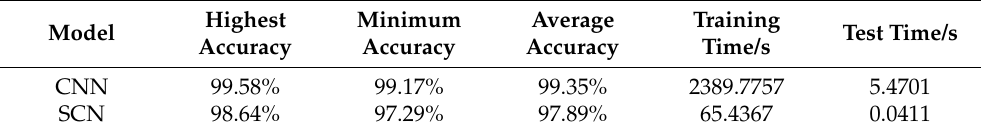
Table 6. Recognition accuracy and average running time of five-classifying models.